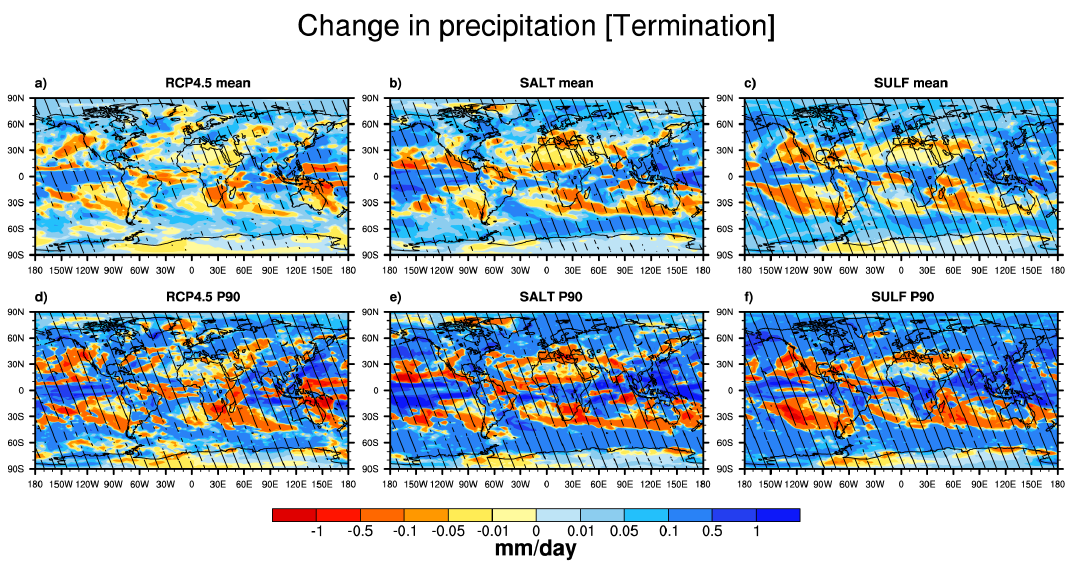
Figure 10. Multi-model mean change in precipitation (mmday − 1 ) during climate engineering termination period for RCP4.5 (left panel), SALT (middle) and SULF (right panel). Panels (a) to (c) denote changes in mean values, (d) to (f) same as (a) to (c) but for the 90th percentile of the temporal distribution at each model grid point. Hatches denote regions where the changes are 95% statistically